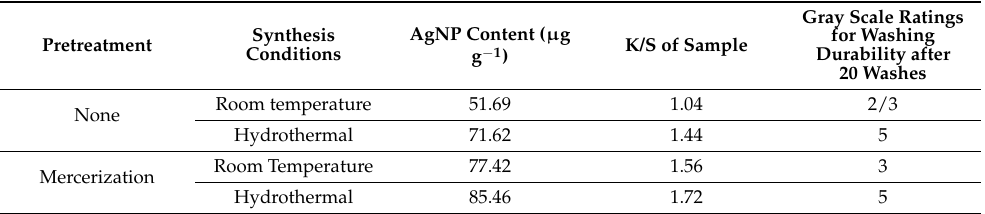
Table 1. Impact of different in situ synthesis conditions on AgNP content of fabric and washing durability of AgNP